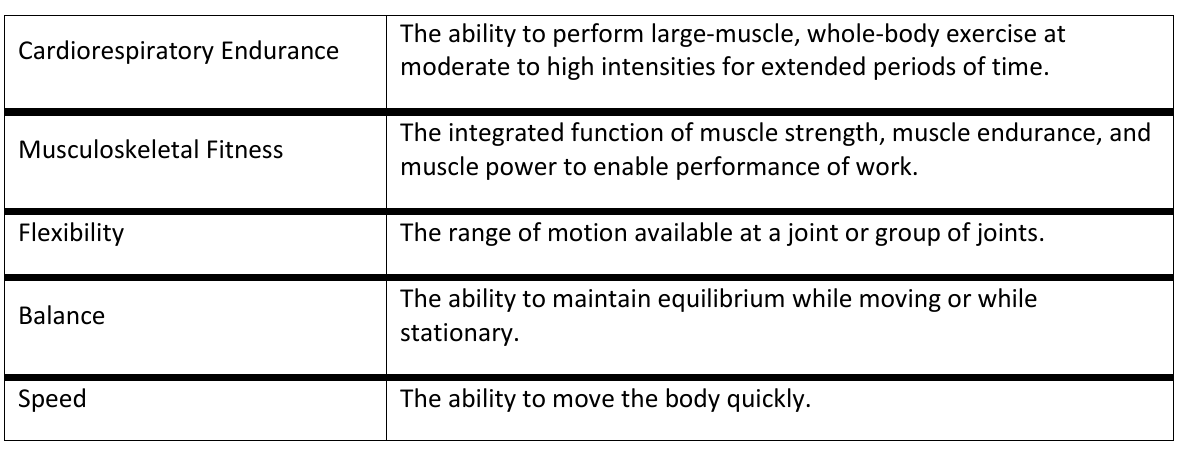
Table C-1. Components of Physical